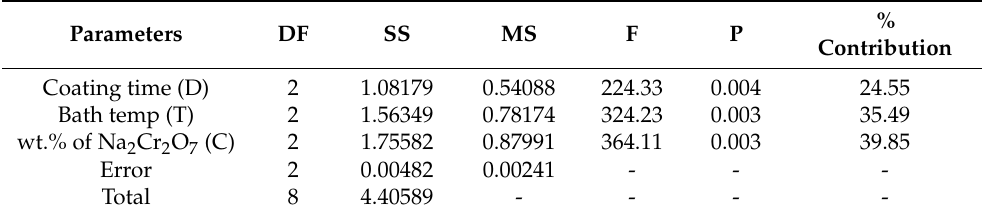
Table 5. ANOVA results for average reflectance value (R).